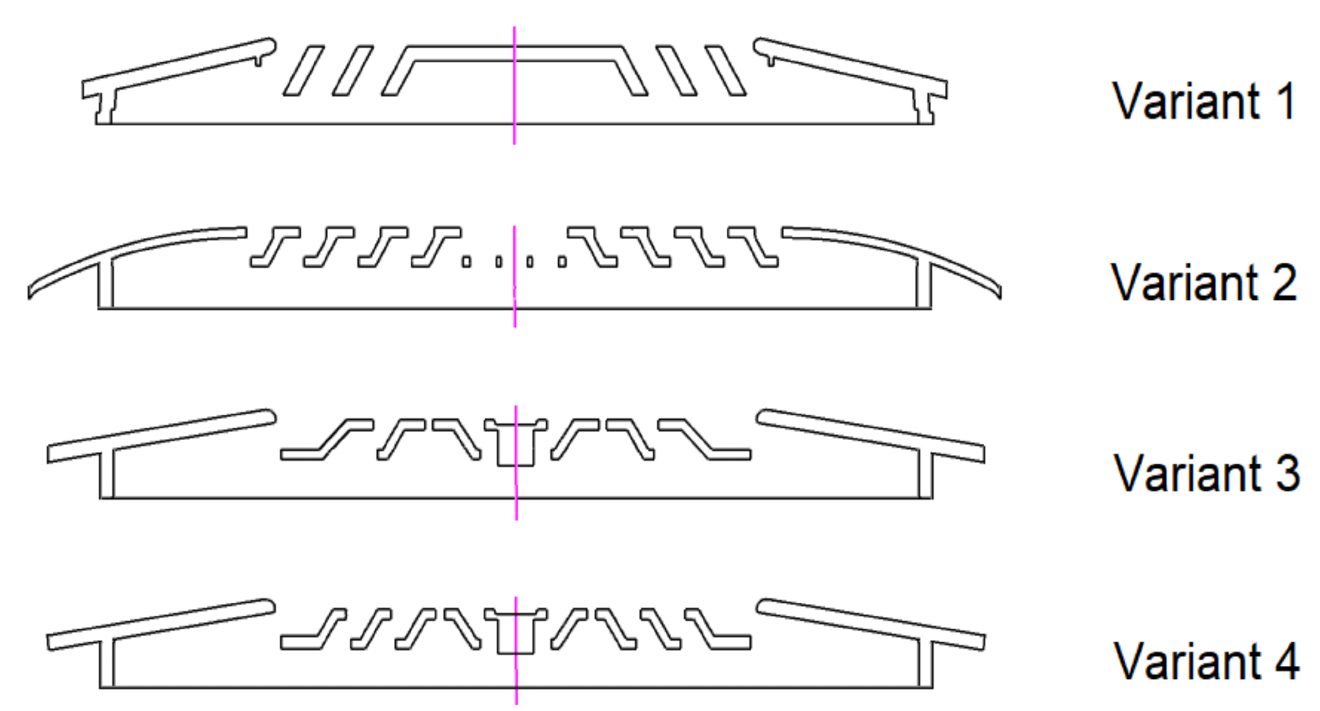
Figure 10. Cross-sections of four variants of canister